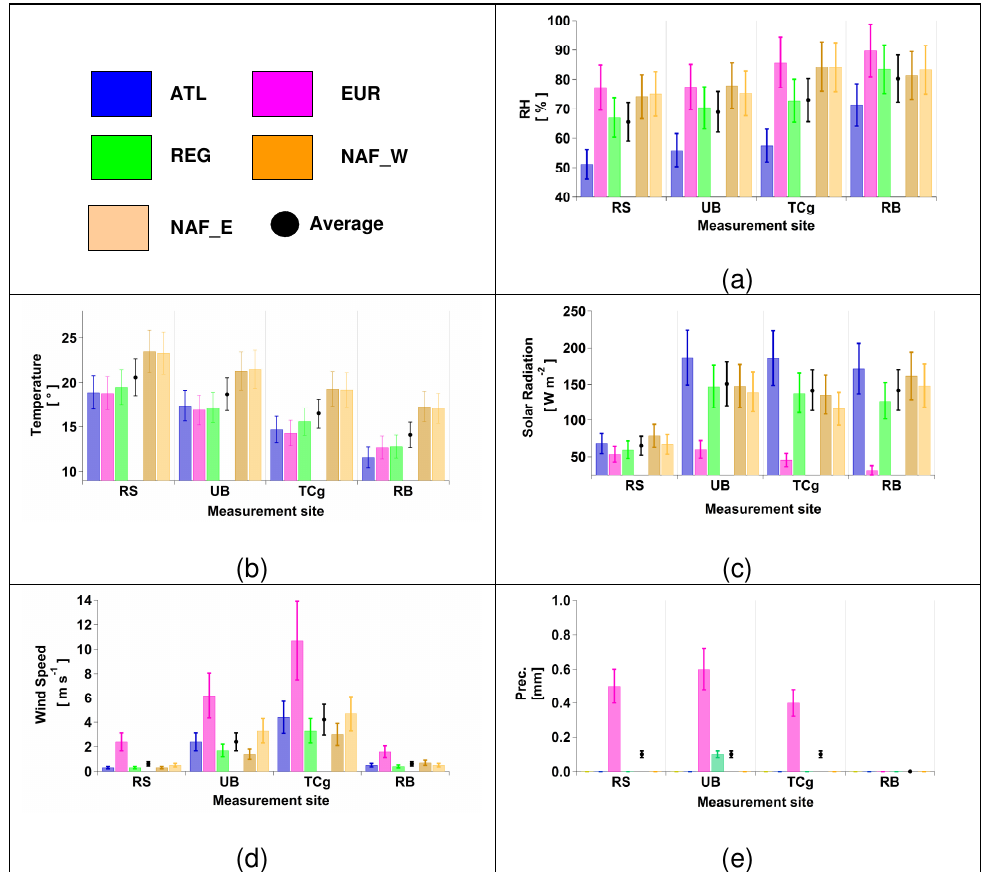
Fig. 4. Average (a) RH, (b) temperature, (c) solar radiation, (d) wind speed and (e) rain precipitation during SAPUSS for different air mass types at four different monitoring sites. Please note black dots show average values during SAPUSS ( ± 1 σ)